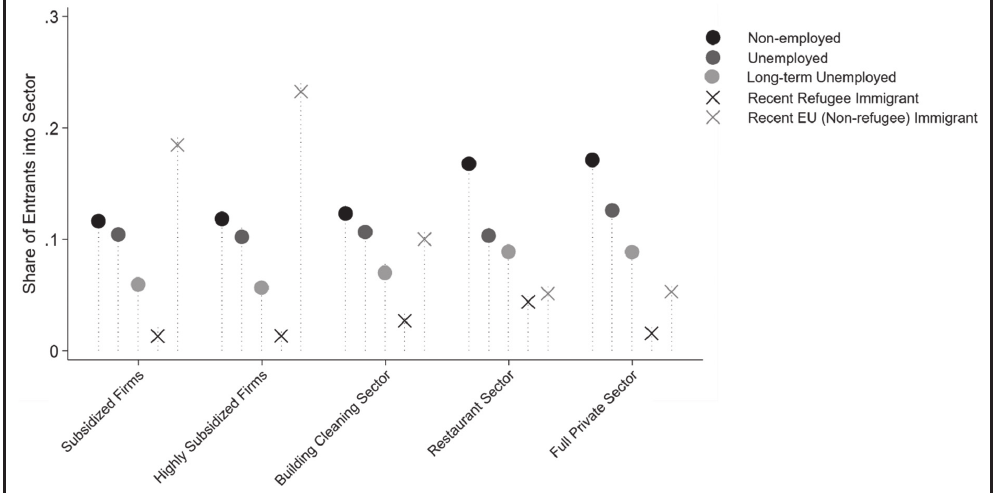
Figure W10 Profile of previous labor market statuses of sector entrants, lower income threshold for defining sector